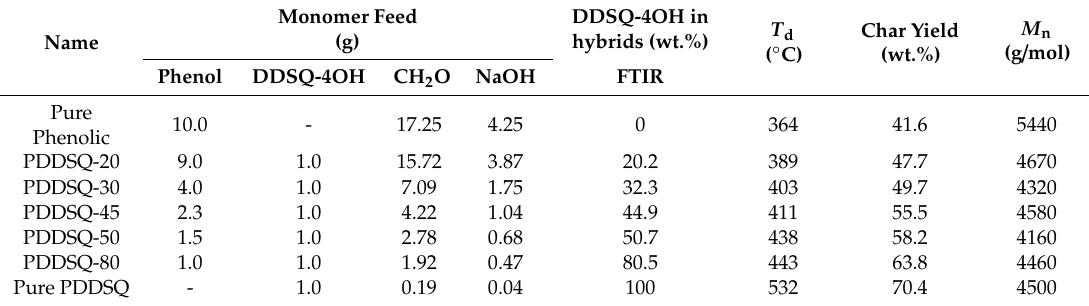
Table 1. Characterization data for the PDDSQ hybrids synthesized in this